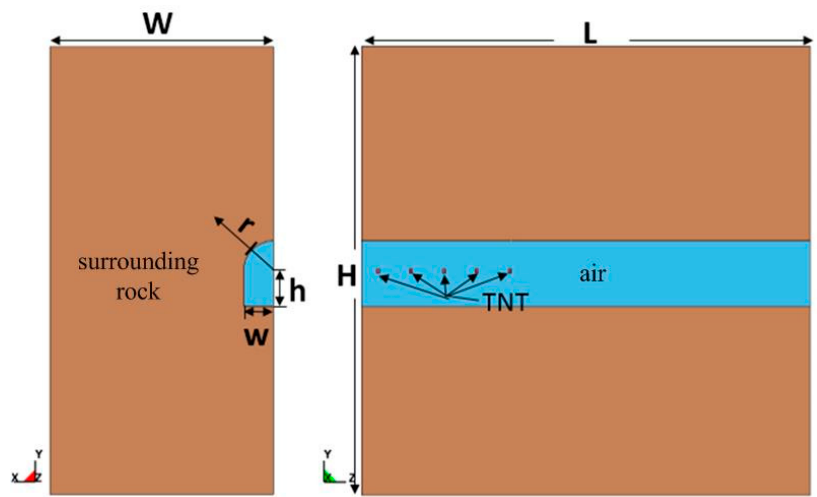
Figure 2. Sketch of model.